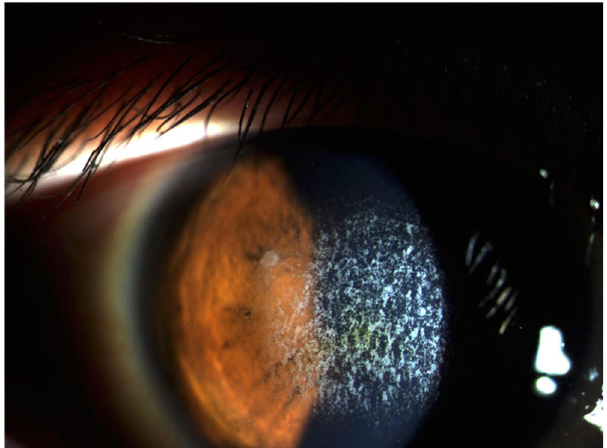
Figure 1. Slit-lamp photography of a patient who was clinically diagnosed with GCD. There were central granular corneal opacities on the cornea.